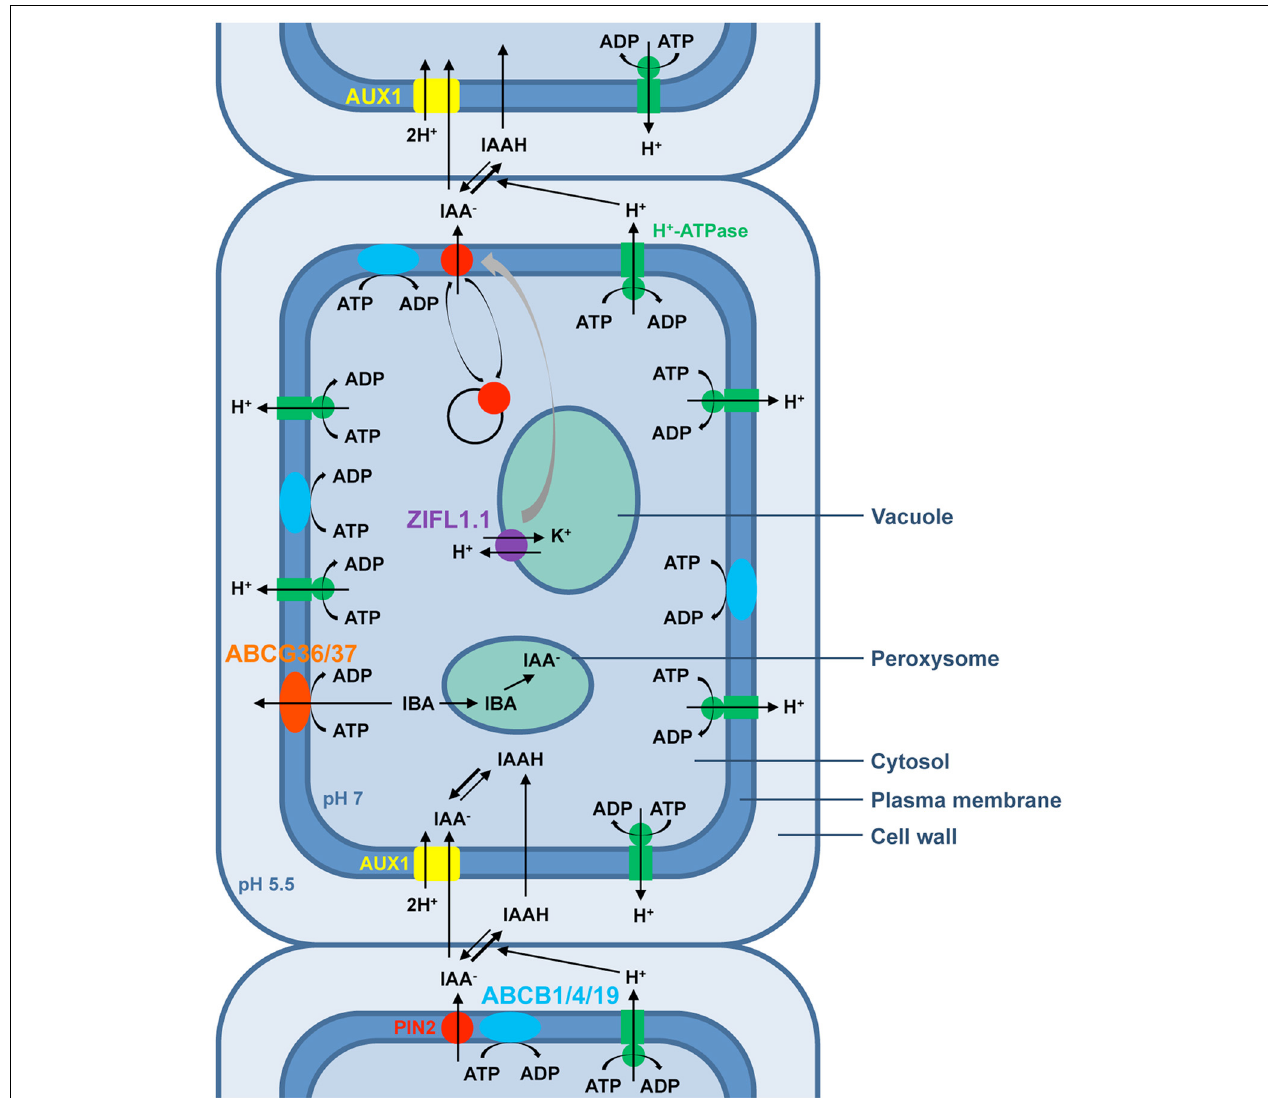
FIGURE 1 | Schematic representation of polar auxin transport (PAT) in epidermal cells of the Arabidopsis root tip. According to the chemiosmotic hypothesis, the proton gradient generated primarily by plasma membrane H + -ATPases between the neutral cytoplasm and the acidic extracellular space drives the polarized auxin cell-to-cell movement. In the acidic apoplastic environment, a fraction of the weak acid IAA exists in its undissociated form, which can passively diffuse through the plasma membrane inside the cell. By contrast, the non-lipophilic and therefore less permeable proton-dissociated auxin fraction requires the amino acid permease-like AUX1, which catalyzes proton symport activity, to enter the cell. In the neutral cytosolic environment, IAA exists mainly in its membrane-impermeant anionic form that requires active transport to exit the cell. Hitherto, two distinct protein families whose members possess IAA-exporting activity have been associated with cellular polar auxin efflux. The best characterized auxin efflux carriers are members of the unique and plant-specific PIN protein family,